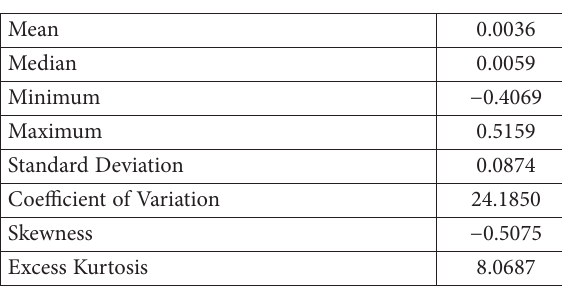
Table 1. Summary